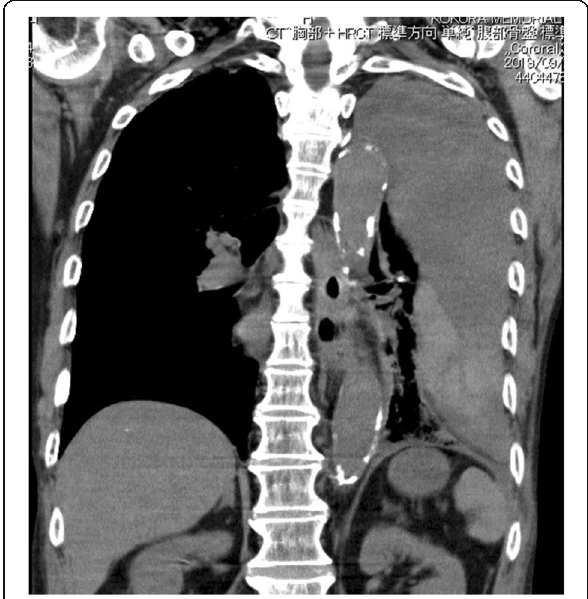
Fig. 5 Chest computed tomography (CT) scan showing a hematoma in tt extrapleural